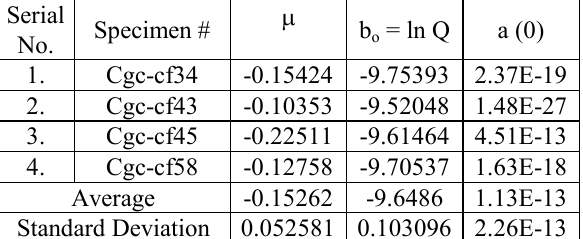
Table 3. Fatigue crack growth parameters for corroded specimens at 5%-6% level.